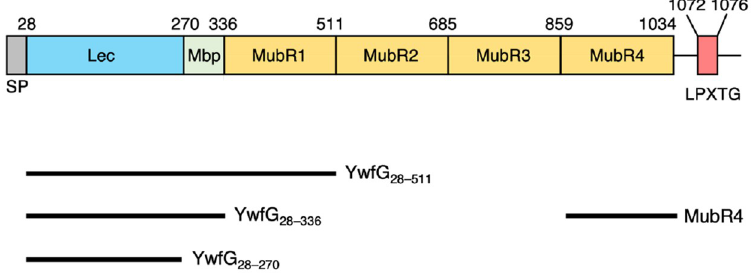
Fig 2. Schematic drawing of YwfG and constructions of variants. (Top) Predicted domain organization of YwfG. (Bottom) Recombinant variants constructed in the present study.